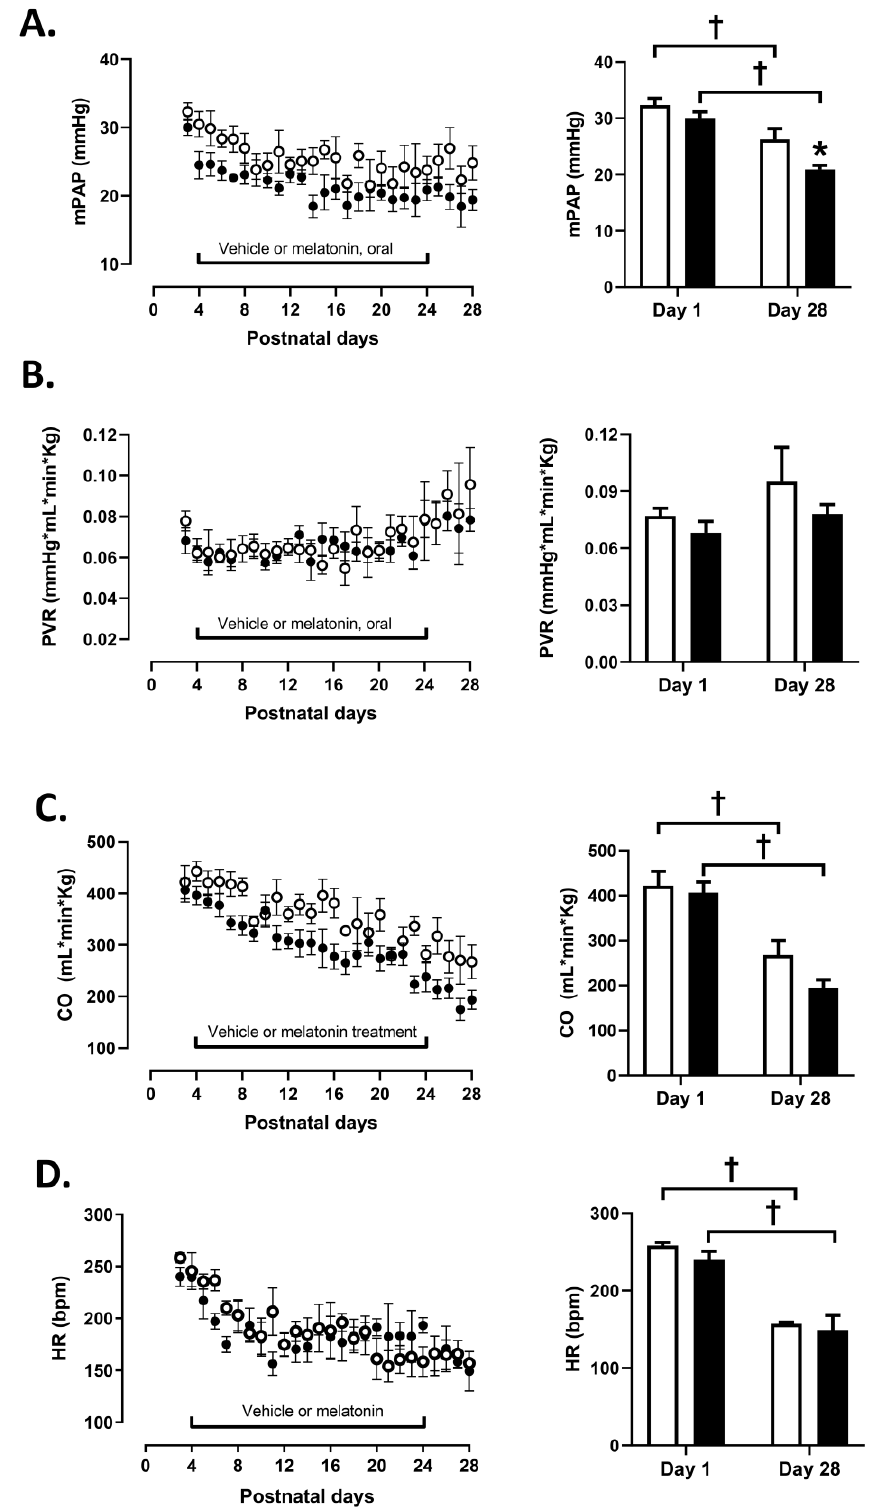
Figure 1. Cardiopulmonary variables during neonatal period. Postnatal cardiopulmonary evolution during the experimental period of the mean pulmonary arterial pressure (mPAP, ( A ), pulmonary vascular resistance (PVR, ( B )), cardiac output (CO, ( C )), and heart rate (HR, ( D )) for controls (C, white symbols, bars) and melatonin treated (M, black symbols, bars). Histograms show the comparison between postnatal day 1 and 28. Data expressed as mean ± S.E.M. Significant differences ( p ≤ 0.05): * vs. CN at equivalent days; † vs. day 1 of the same group.